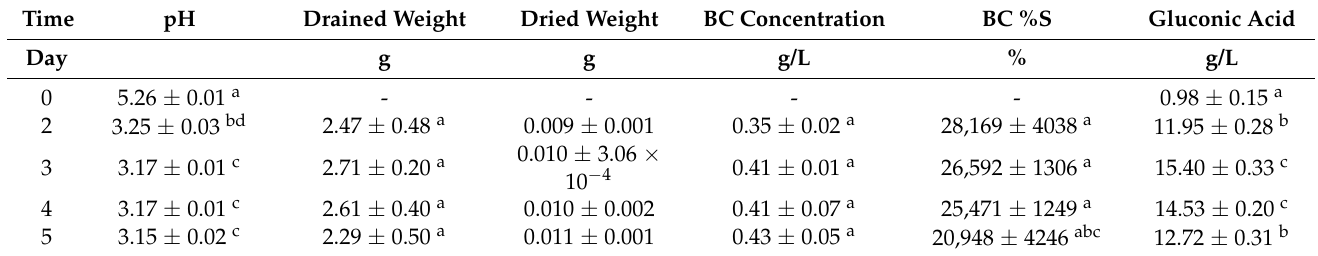
Values are expressed as mean ± standard deviation (SD). Different letters in the same column indi- cate significant differences ( p > 0.05). Table 2. Parameters analyzed at each incubation time in control culture medium: pH, bacterial cellulose (BC) drained weight (g), BC dried weight (g), BC concentration (g/L), BC swelling capacity (%S) and gluconic acid concentration (g/L).